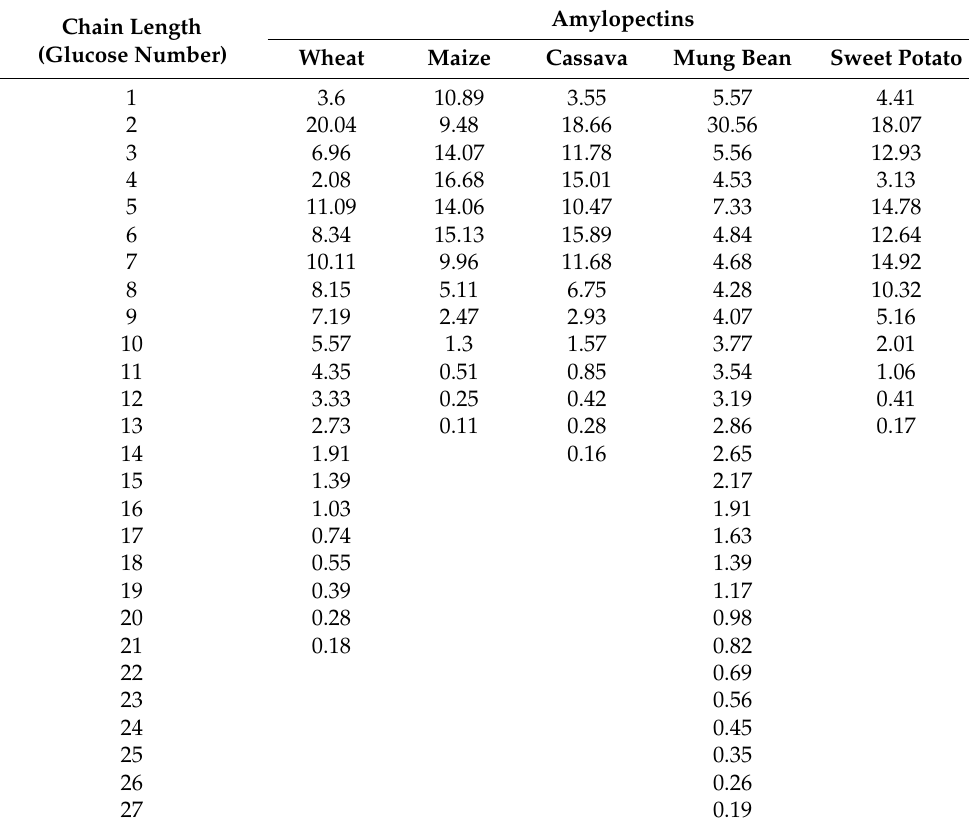
Table 3. Chain length characteristics of different amylopectin isolated by freeze–thawing + 0.5% NaCl dissolution